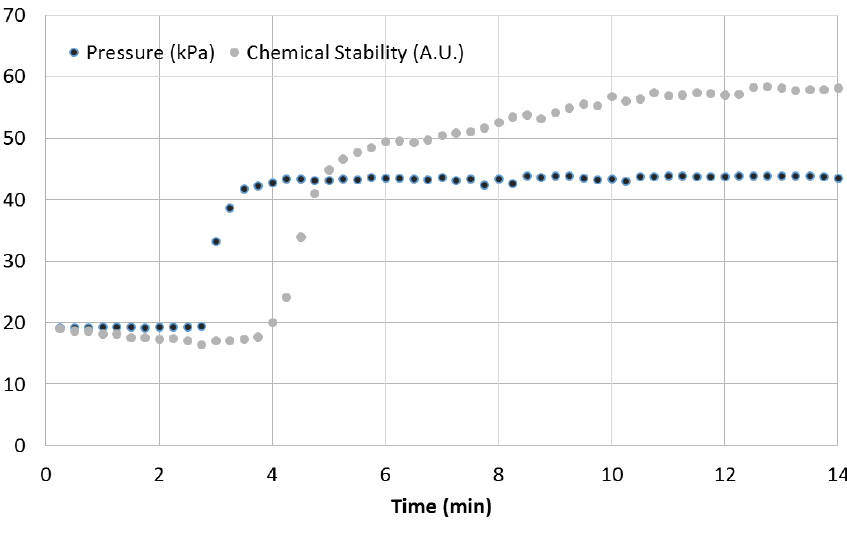
Figure 5. Pressure response in a reagent line ( dark dotted line ) and chemical yield information ( light dotted line ) that demonstrate physical and chemical steady states and changes in the system. At 3 min, the flow rates of the four reagent lines were doubled. The pressure sensor indicates physical steady state occurring in the reactor at 4 min, and the chemical yield response demonstrates chemical steady state occurring in the reactor at 13 min.